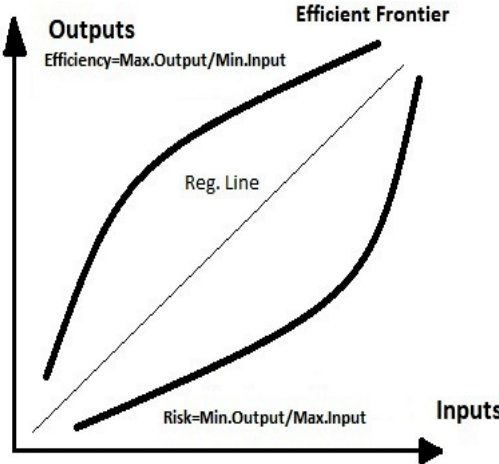
Figure 2. Conceptual-DEA frontier pattern with reference to regression .